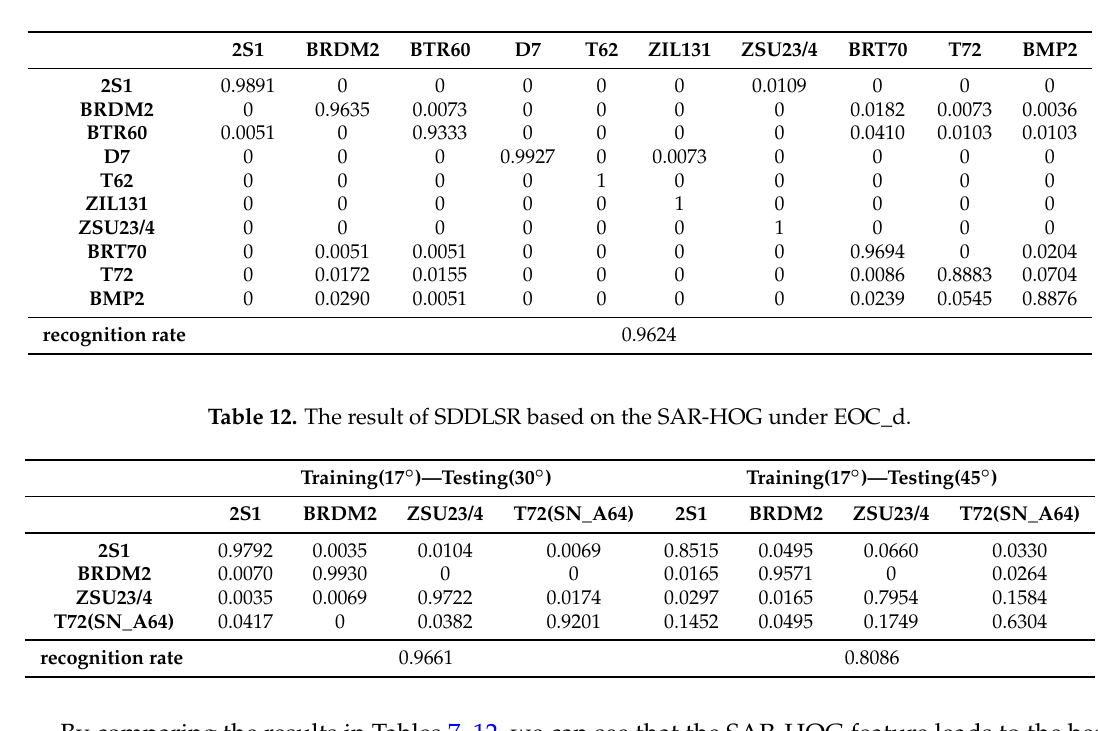
Table 11. The result of SDDLSR based on SAR-HOG under SOC.